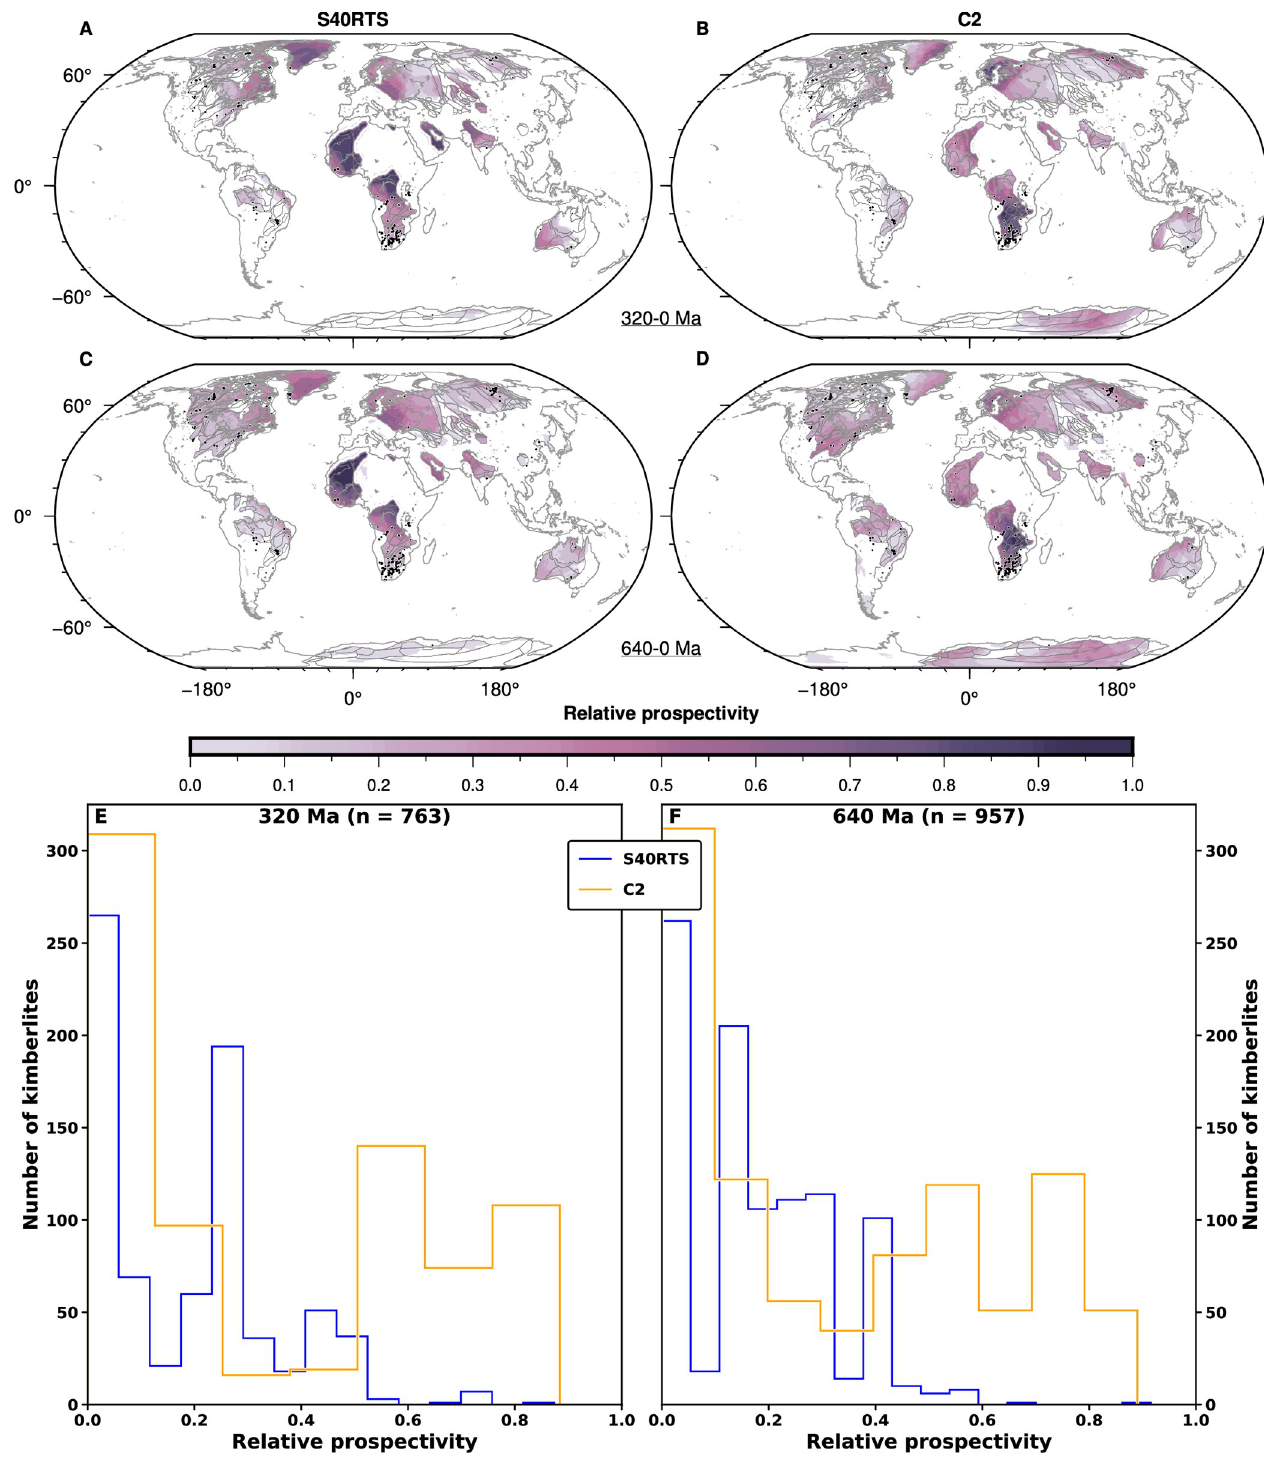
Fig 9. Predicted relative kimberlite potential. A-D/ Global relative kimberlite potential maps for lithosphere thicker than 150 km from 320 Ma ( A-B ) and from 640 Ma ( C-D ) for tomographic model S40RTS ( A, C ) and Case 2 ( B, D ). Kimberlites from ref. [22] are shown as black circles for the last 320 Ma ( A - B ) and 640 Ma ( C - D ). These figure panels were created with GMT6 [47] and the Global Self-consistent, Hierarchical, High-resolution Geography Database (GSHHG) coastlines are republished from [48] under a CC BY license, with permission from Paul Wessel, original copyright 1996. E-F/ Distribution of relative kimberlite potential at kimberlite locations shown in A-D for S40RTS and Case 2 from 320 Ma ( E ) and from 640 Ma ( F ).